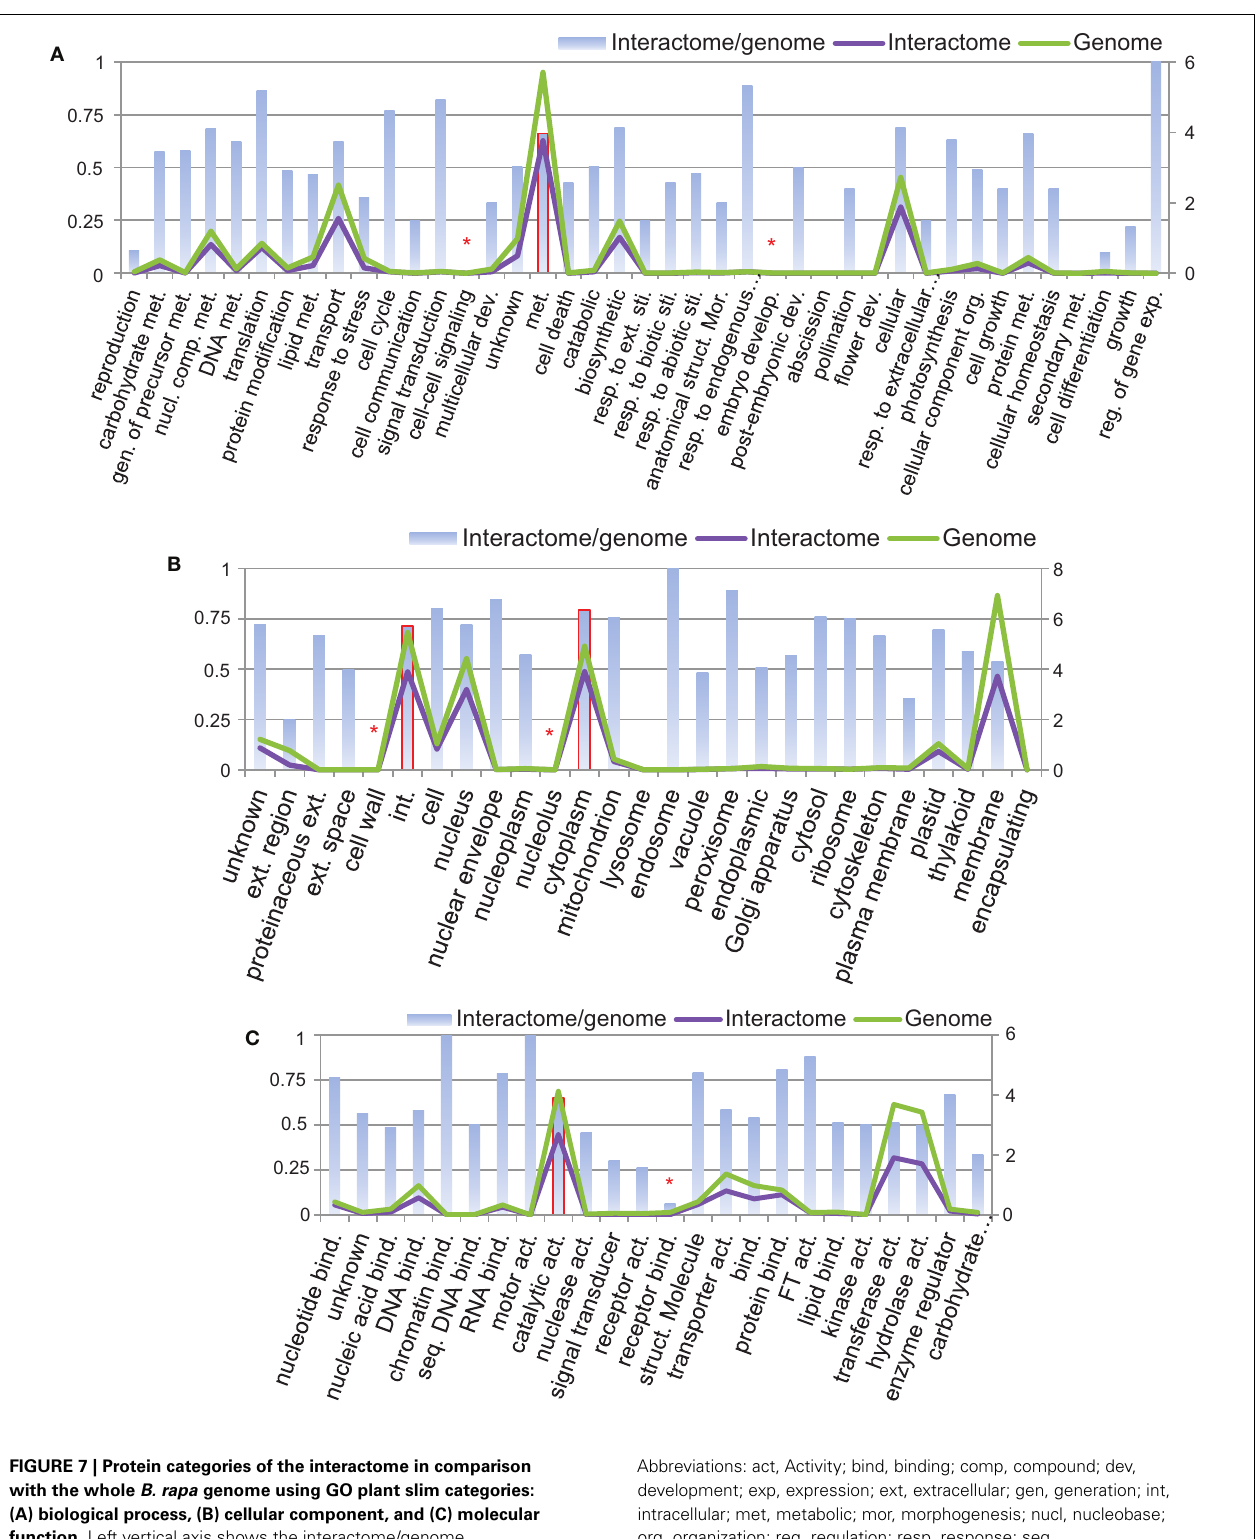
FIGURE 7 | Protein categories of the interactome in comparison with the whole B. rapa genome using GO plant slim categories: (A) biological process, (B) cellular component, and (C) molecular function. Left vertical axis shows the interactome/genome percentage. Right vertical axis shows protein counts in units of